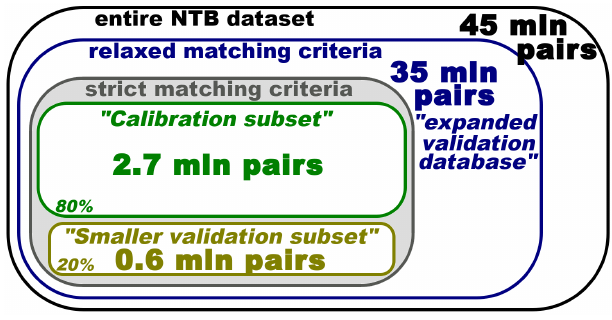
Figure 2. Schematic overview of data preparation